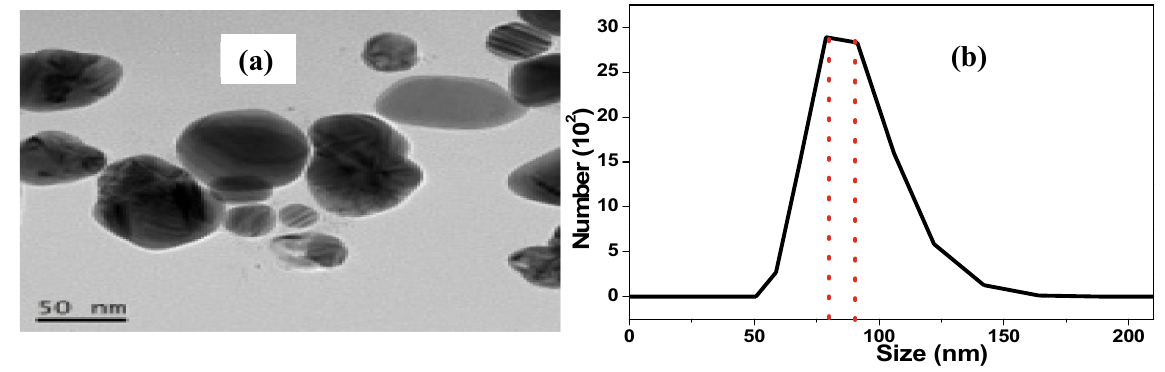
Fig. 5 a TEM images of Et-AgNPs and b Distribution of hydrodynamic size of Et-AgNPs by DLS intensity